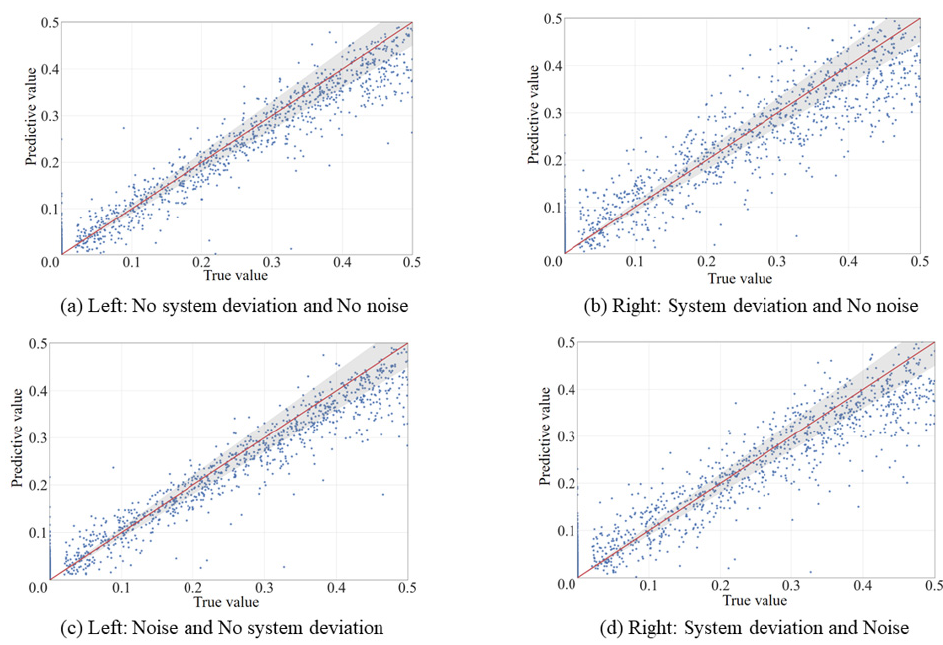
Figure 10. Regression curve of blade crack degree detection results.